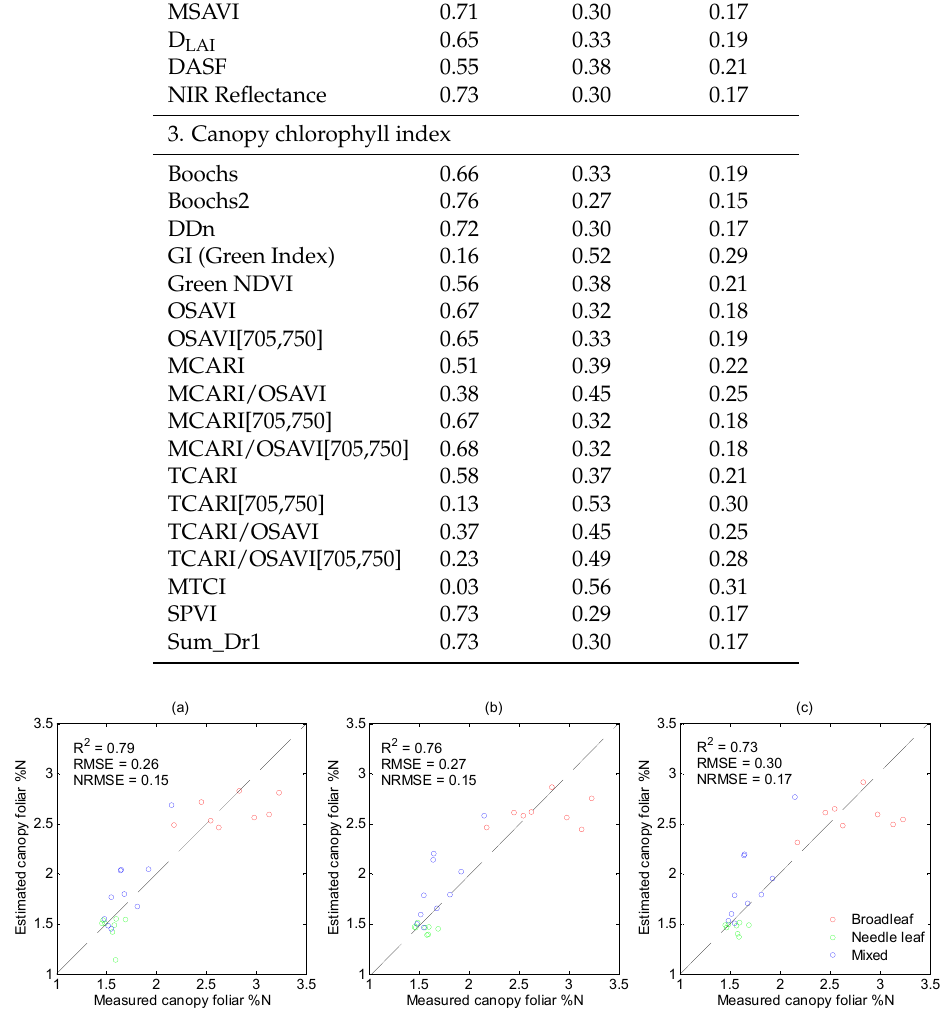
Figure 3. The 1:1 relationship between the estimated and measured canopy foliar %N based on best performing vegetation indices: ( a ) NDNI 1510 ; ( b ) Boochs2; and ( c ) NIR BRF, 800–850 nm. R 2 , RMSE, and NRMSE are values from leave-one-out cross-validation.